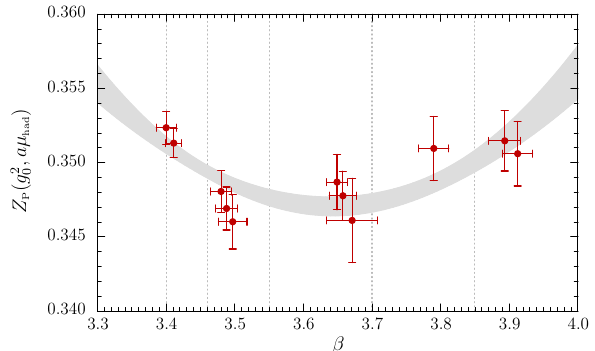
Z tm connecting M and M